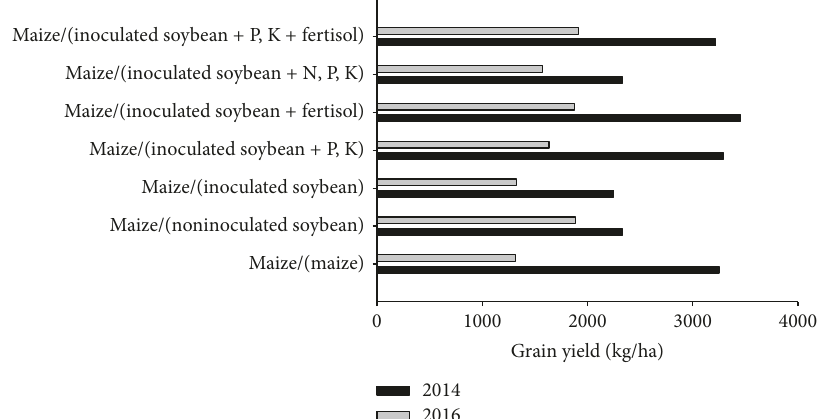
Figure 2: Grain yield of maize as affected by amended soybean rotations in the 2014 and 2016 cropping seasons in the northern savanna of Ghana. inoc.: inoculants and fert: